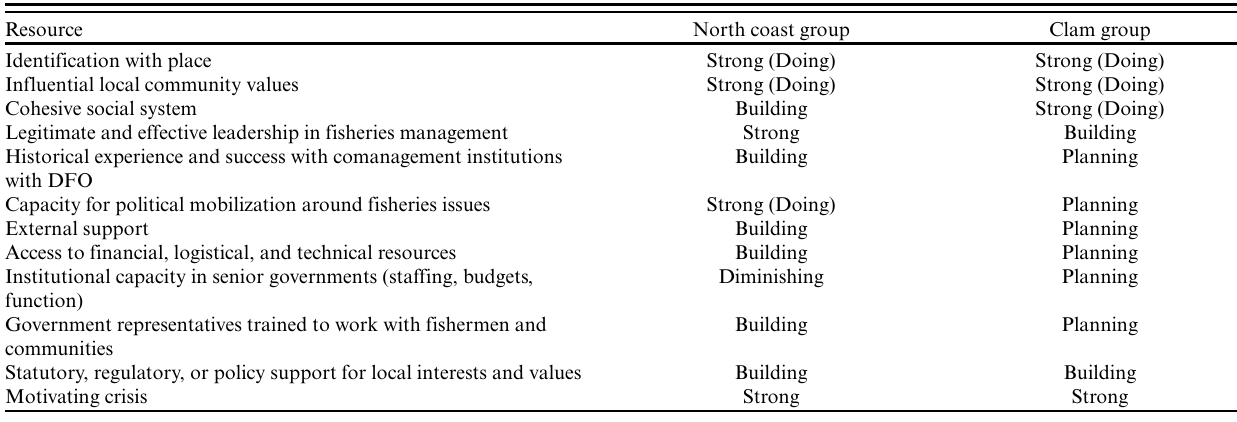
Table 8 . Resources that support rebuilding local fisheries management institutions: assessment and comparison of north coast and clam groups. DFO = Canadian Department of Fisheries and